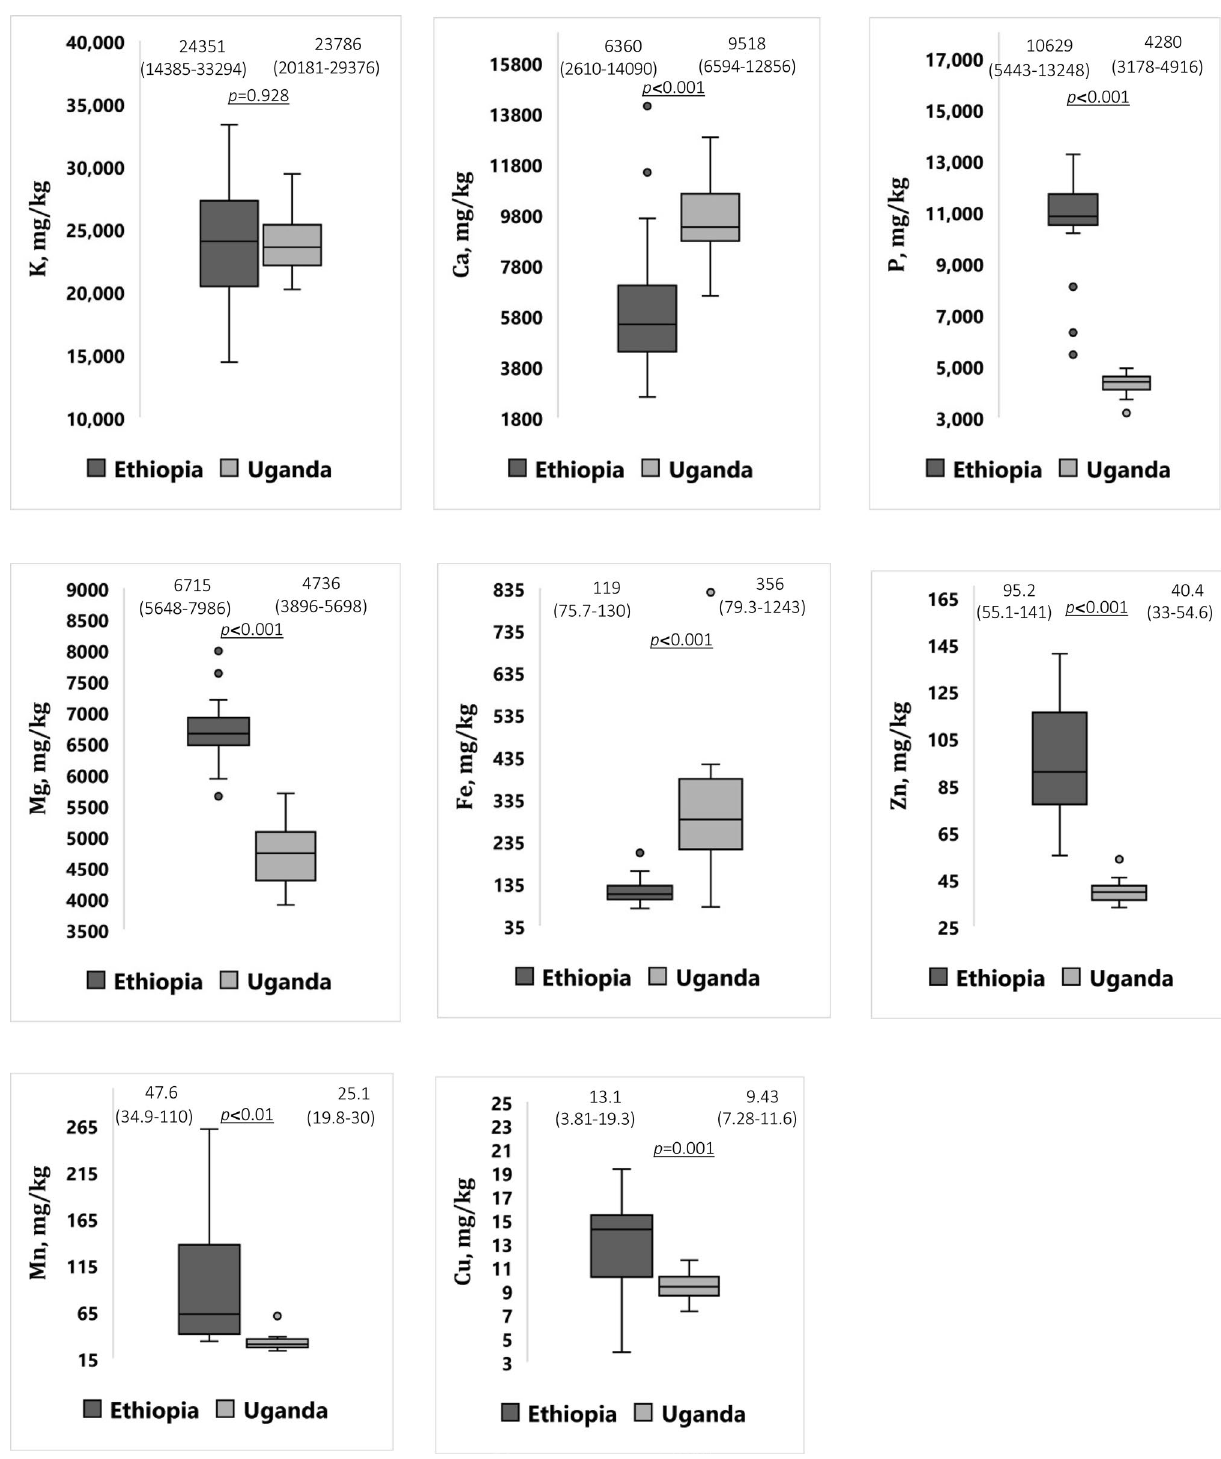
the bottom and top of the box signify the first and third quartiles, respectively. The whiskers are the lines that extend from the bot- tom and top of the box to lower and upper bounds calculated from the data. Values outside these limits represent